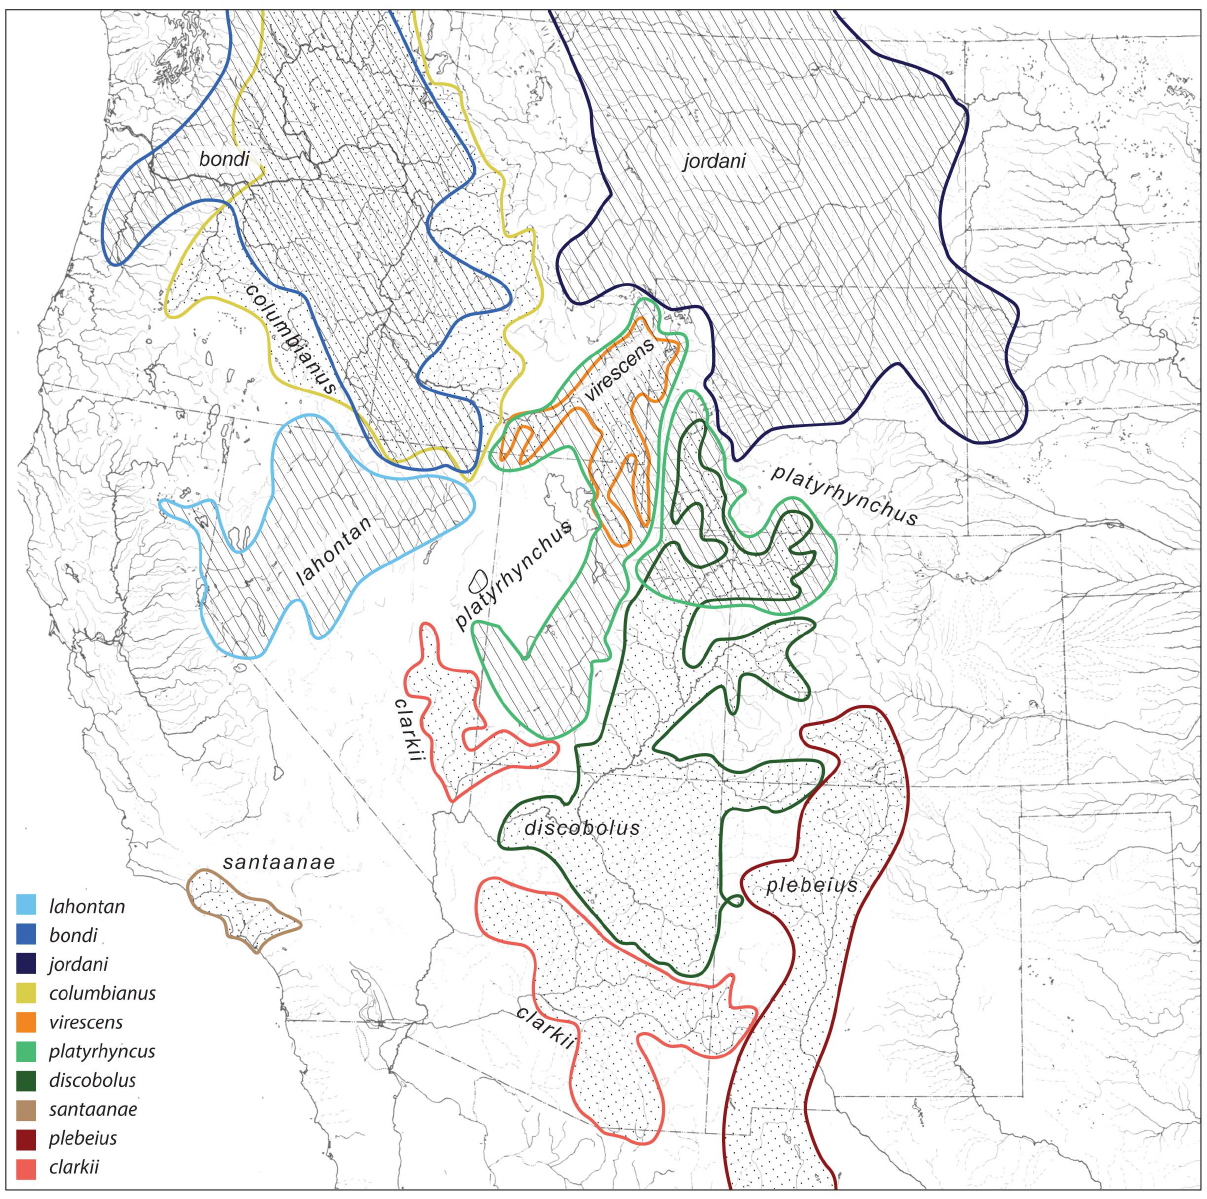
Figure 2. Distribution of the 11 species of Pantosteus . Border species are found north and south of the margins of this map.